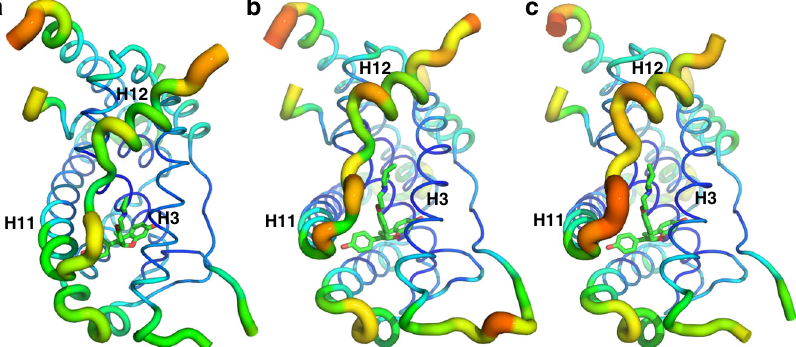
Fig. 6 OP-1074 increases H12 mobility in the crystal structure. B-factor putty representation of the OP-1156 ( a ), OP-1154 ( b ), and OP-1074 ( c ) compounds in complex with ER α LBD. Cool colors (blues) with small diameter tubes indicate lower B-factors and less mobility in the crystal. Hot colors (reds) with large diameter tubes are indicative of higher B-factors and increased mobility in the crystal. Helices 3, 11, and 12 are labeled H3, H11, and H12